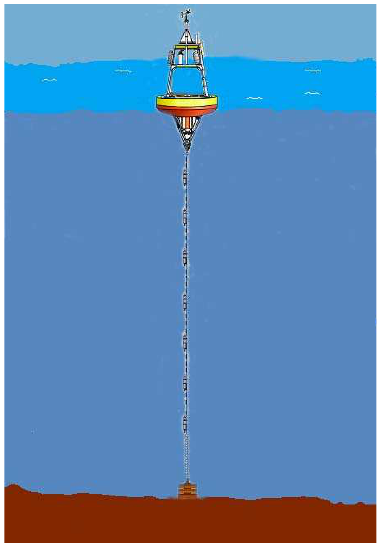
Figure 1. Underwater acoustic moored monitoring